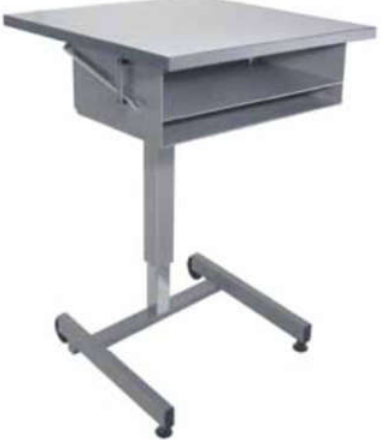
Figure 1. Model of the used standing desk adopted by Hüba AG.